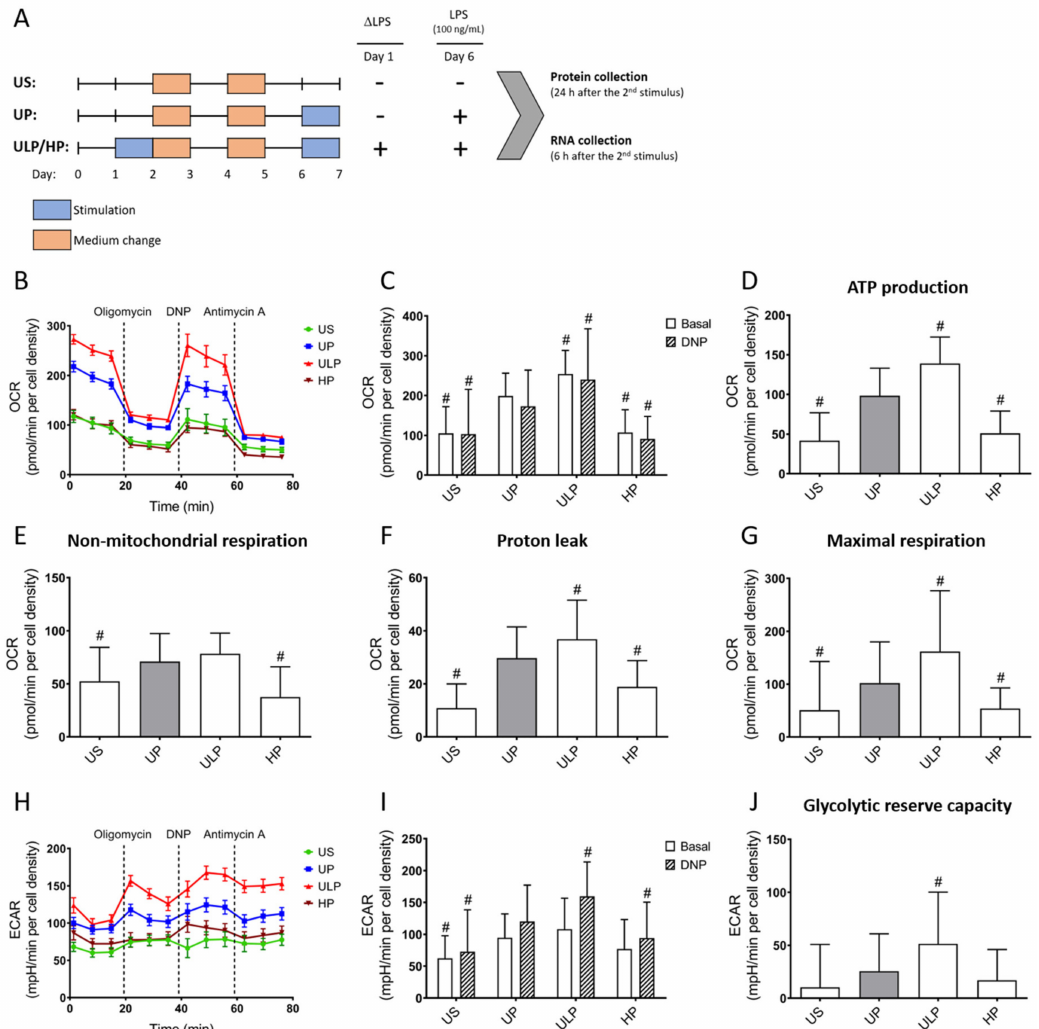
Figure 1. Reversed metabolism as a hallmark of LPS-induced innate immune memory (IIM). ( A ) Illustration of the two- step approach to induce memory-like inflammatory responses in primary microglial cell cultures. Measurement of ( B ) oxygen consumption rates (OCR) with ( C ) quantification under basal and 2,4-dinitrophenol (DNP, inducing uncoupled mitochondrial respiration) treatment. ( H ) Extracellular acidification rates (ECAR) with ( I ) quantification under basal and DNP treatment (n = 6, repeated measurements were performed 24 h after the second stimulus with LPS (100 ng/mL) using a Seahorse assay). ( D ) Mitochondrial ATP production, ( E ) non-mitochondrial respiration, ( F ) proton leak and ( G ) maximal respiration were calculated from OCR values. ( J ) Glycolytic reserve capacity was calculated from respective ECAR values. Microglia isolated from newborn mice were primed initially by ultra-low (ULP, 1 fg/mL) or high (HP, 100 ng/mL) doses of LPS, followed by the second stimulation (day 6) with 100 ng/mL LPS. Data were normalized and compared to unprimed microglia (UP group without any stimulation at day 1 with stimulation at day 6 with a fixed dose of LPS, 100 ng/mL). Unstimulated microglia (US) served as the negative control. Data from B, H are given as means ± SEM, data from ( C – G , I , J ) are presented as means + SD, # p < 0.05 vs. unprimed conditions (UP, grey